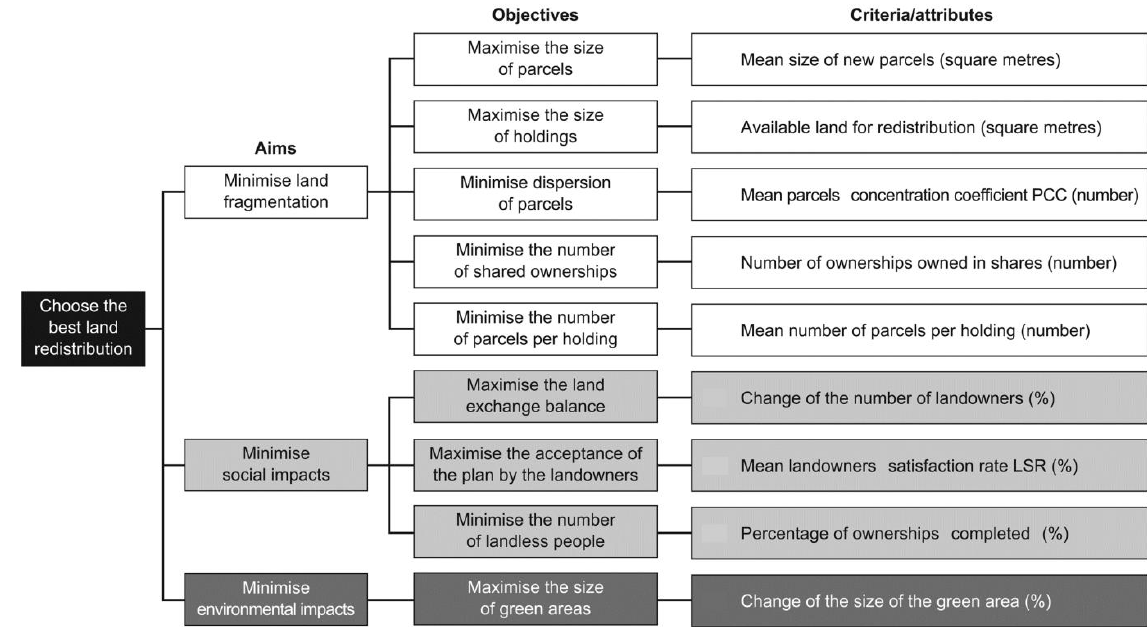
Figure 2. The objective tree for the land redistribution